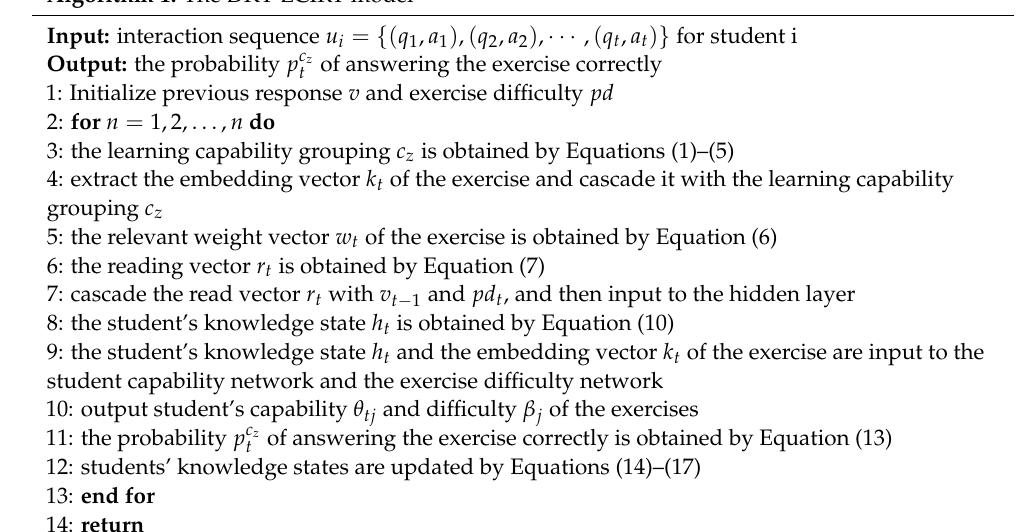
Algorithm 1: The DKT-LCIRT model